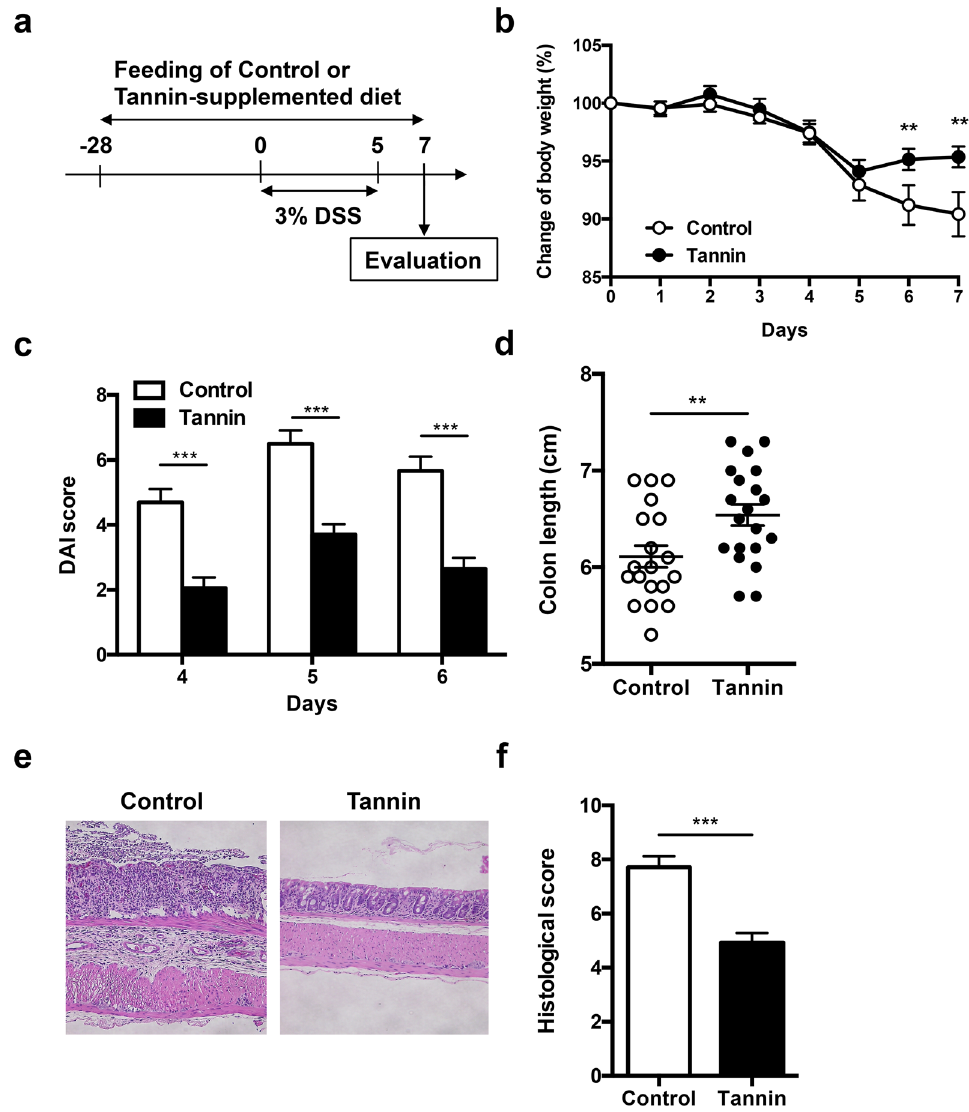
Figure 1. Amelioration of DSS-induced colitis by dietary supplementation of persimmon-derived tannin. ( a ) Schematic model of the experimental design. Female BALB/c mice were fed the control or tannin-supplemented diet for 4 weeks and then administered 3% DSS in drinking water for 5 days. ( b , c ) Weight changes ( b ) and disease activity index ( c ) calculated from weight loss, stool consistency, and rectal bleeding were monitored after DSS administration. ( d ) Colon length was measured in colitis-induced mice at day 7. ( e ) Sections of the proximal colon region were stained with haematoxylin and eosin. ( f ) Histological score was calculated from the severity of inflammation, thickness of inflammatory involvement, epithelial damage, and the extent of lesions. Data are shown as the mean ± SEM of three independent experiments (control diet group n = 19, tannin diet group n = 20). ** p < 0.01, *** p <